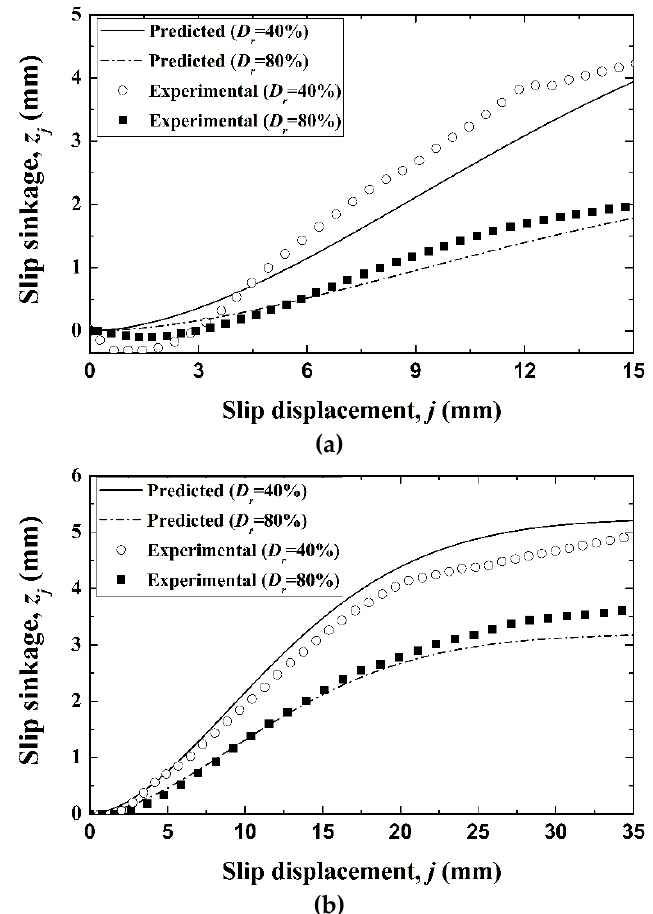
Figure 13. Comparison between experimental values and the values predicted by the proposed model: ( a ) Model ( a ); and ( b ) Model ( b ). ( a ) Model ( a ); and ( b ) Model ( b